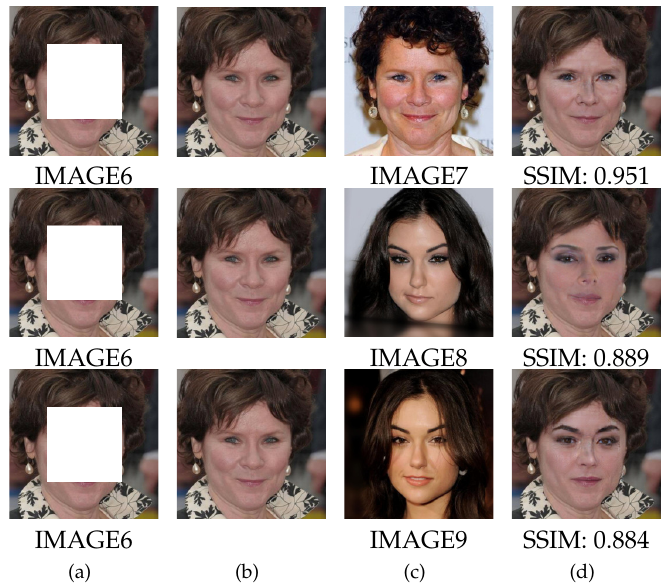
Figure 9. The completion results of a masked IMAGE6 using different reference face images: ( a ) masked input; ( b ) ground-truth; ( c ) reference face images; ( d ) results of RG-DP-FICN.